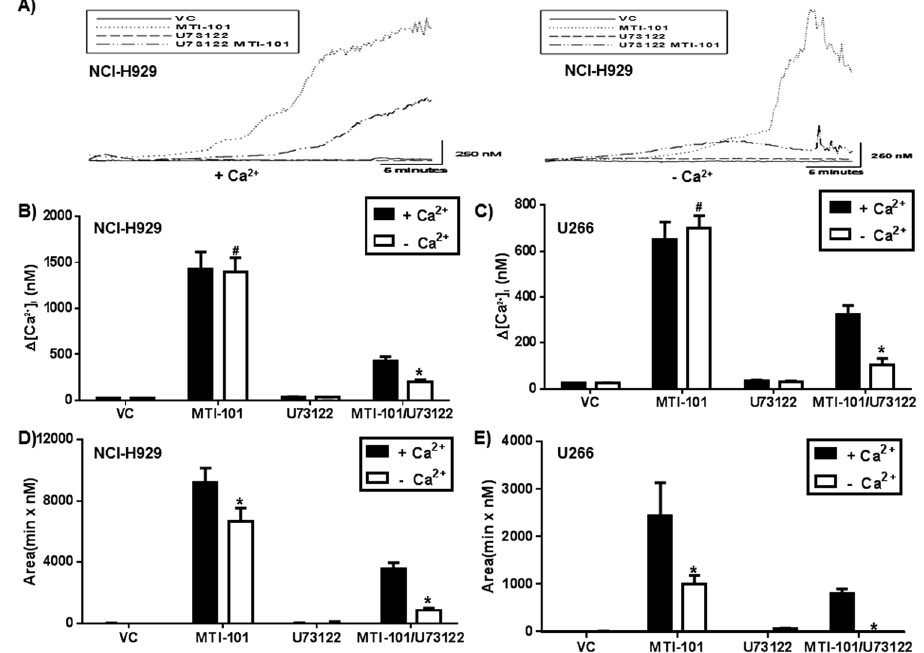
Figure 2. MTI-101 triggers release of ER Ca 2 + stores and influx of Ca 2 + entry by plasma membrane store operated channels (SOC). ( A ) MTI-101 mediated intracellular Ca 2 + levels were measured by using Fura-2 dye. NCI-H929 cells were adhered to cell-tak coated plates and then incubated with Fura-2 dye + / − 2 uM U73122 for 30 min in PSS containing Ca 2 + and PSS without Ca 2 + . Time-lapse images were taken every 10 seconds for 30 min after treatment with 3 µ M MTI-101. A representative H929 cell closest to the median Ca 2 + response of the whole population is shown. The peaks were then measured and subtracted from the baseline Ca 2 + levels. A representative experiment for ( B ) NCI-H929 and ( C ) U266 is shown. ( D and E ) The total level of Ca 2 + induced by MTI-101 was determined by measuring the area under the curve for each individual cell. A one-way ANOVA test determined significance ( # p > 0.05; * p < 0.05; n = 30 or greater). Shown is a representative experiment performed in